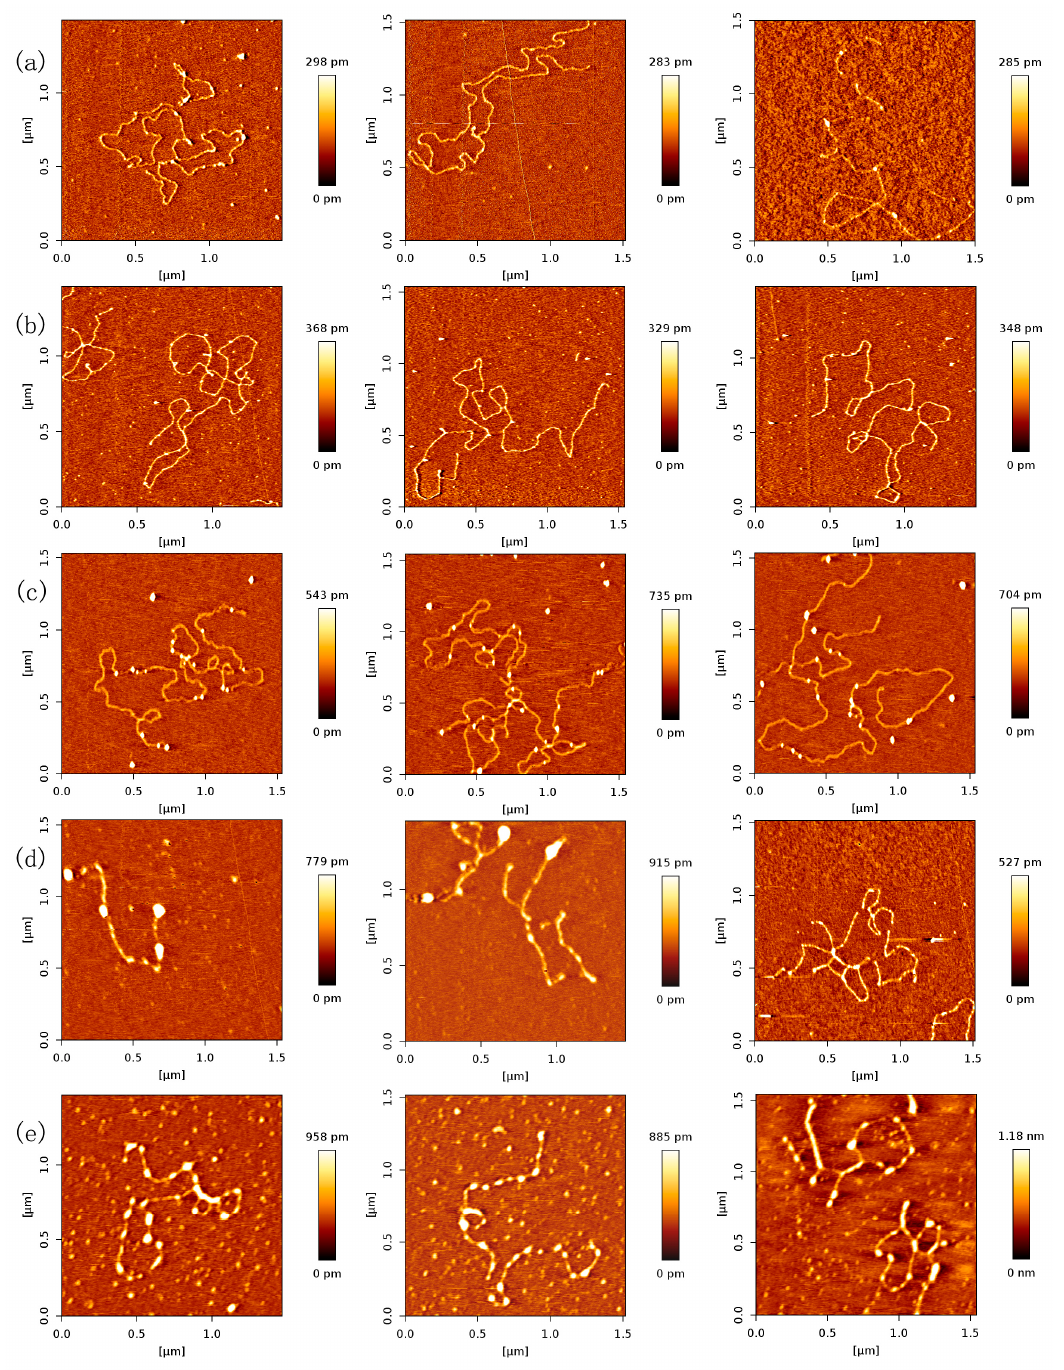
Figure 2. AFM images of p53 and 20,000 bp DNA (height images, 1.5 µm × 1.5 µm), when the concentration ratio of p53:DNA is 1:1, 1.5:1, 2:1, 2.5:1, 3:1, respectively. Meanwhile, the concentration of p53 and DNA are ( a ) 1 and 1 ng/µL; ( b ) 1.5 and 1 ng/µL; ( c ) 2 and 1 ng/µL; ( d ) 2.5 and 1 ng/µL; ( e ) 3 and 1 ng/µL, respectively. The environment of the solution is 5 mM Hepes, 3 mM MgCl 2 , pH 7.5.